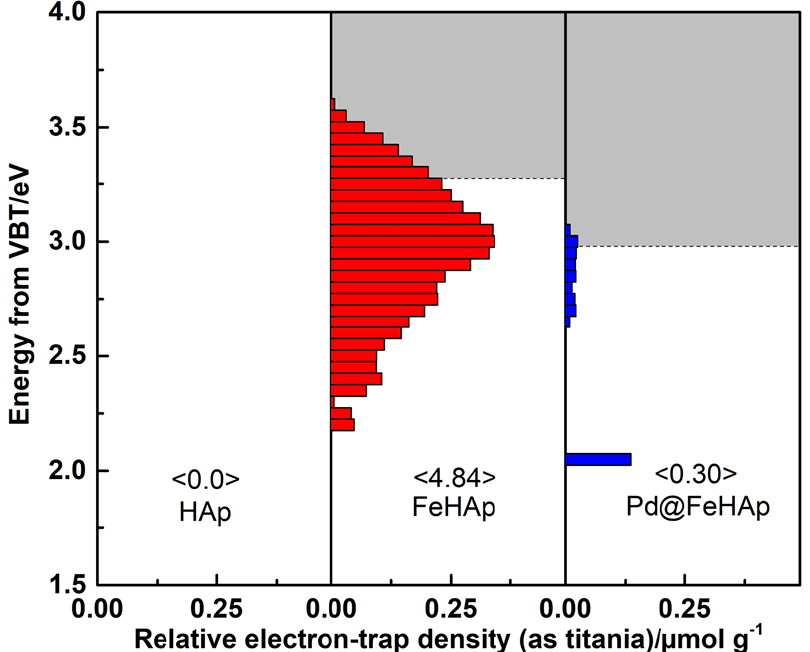
Figure 8. ERDT/CBB patterns including relative total electron trap density in brackets of HAp, FeHAp, and Pd@FeHAp.